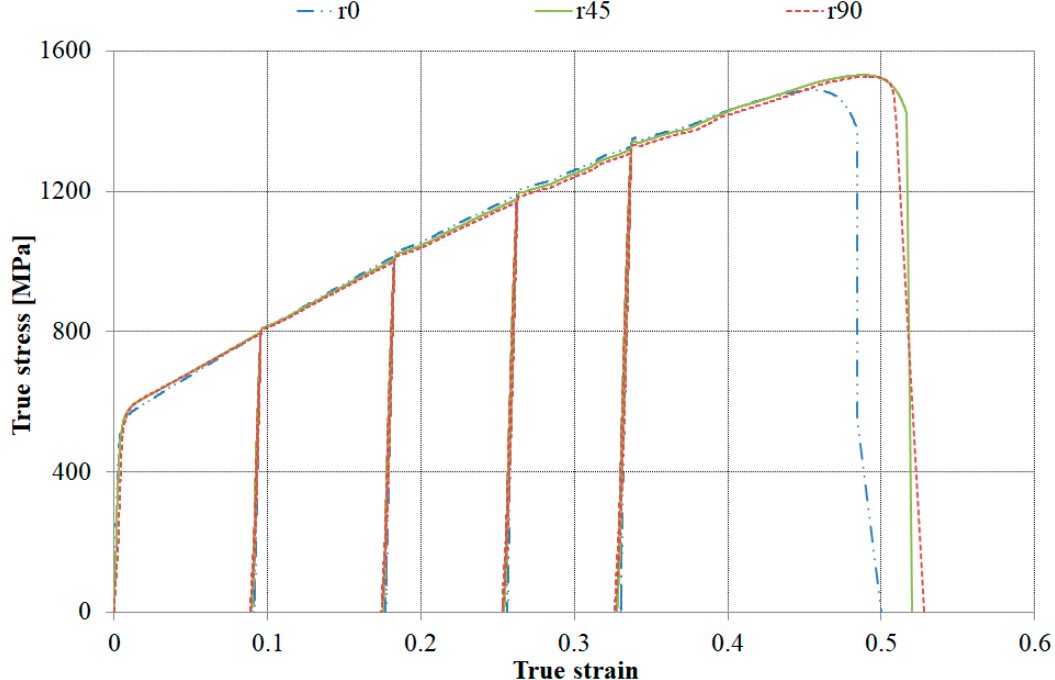
Figure 8. True stress–strain curves obtained in the tensile loading–unloading cycles, for undeformed samples and θ of 0°, 45°, and 90°.